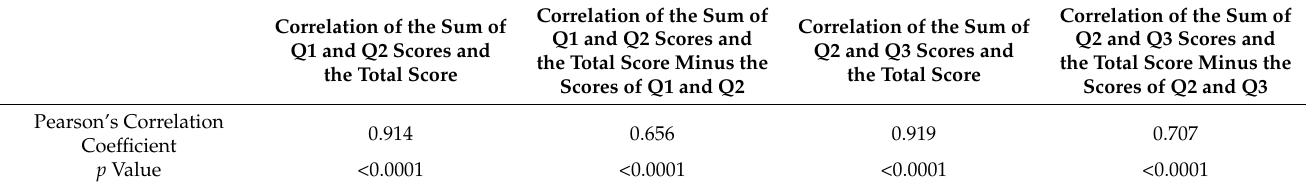
Table 6. Correlation with total score based on sub-questionnaire selection in method (7). Correlation of the Sum of Correlation of the Sum of Correlation of the Sum of Correlation of the Sum of Q2 and Q3 Scores and Q1 and Q2 Scores and Q2 and Q3 Scores and Q1 and Q2 Scores and the Total Score Minus the the Total Score Minus the the Total Score the Total Score Scores of Q2 and Scores of Q1 and Q2